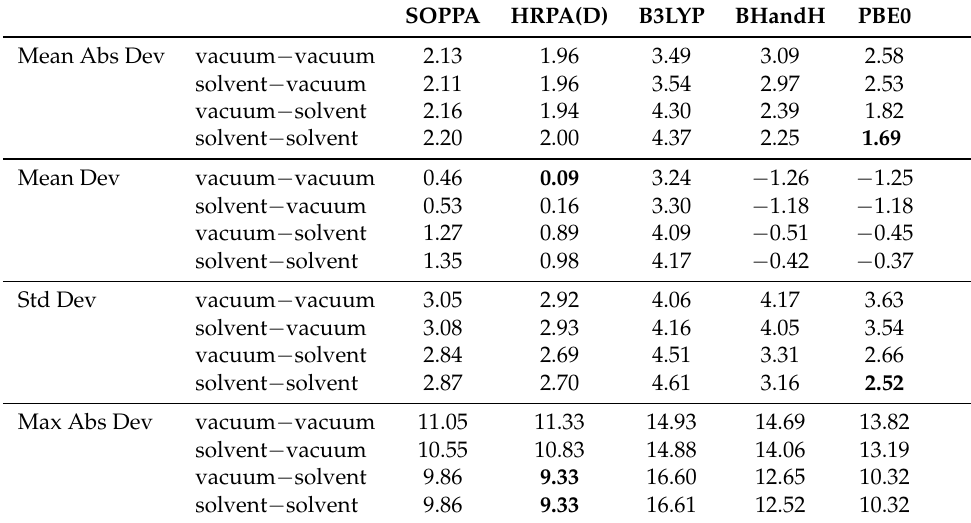
Figure 2. The statistics for the 242 calculated coupling constants with the experimental values as references. Table 2. The statistics data for all the